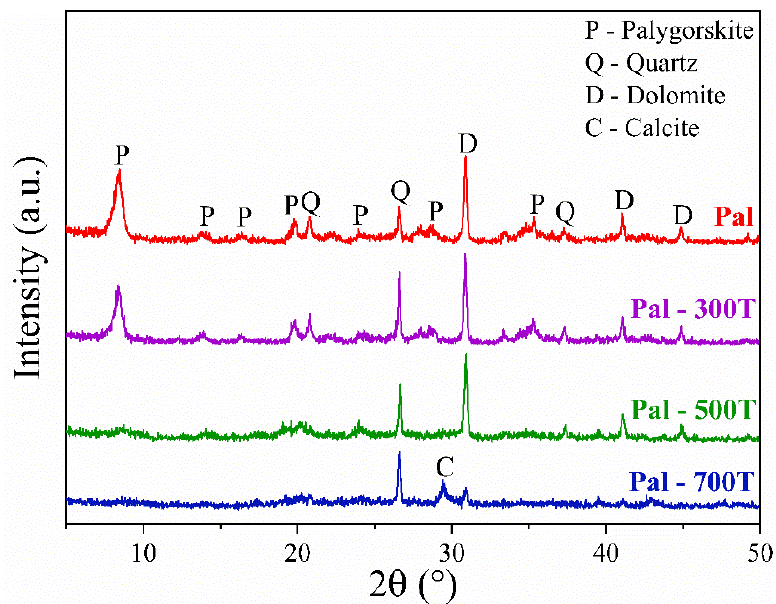
Figure 1. Palygorskite XRD patterns before and after heat treatment at different temperatures.